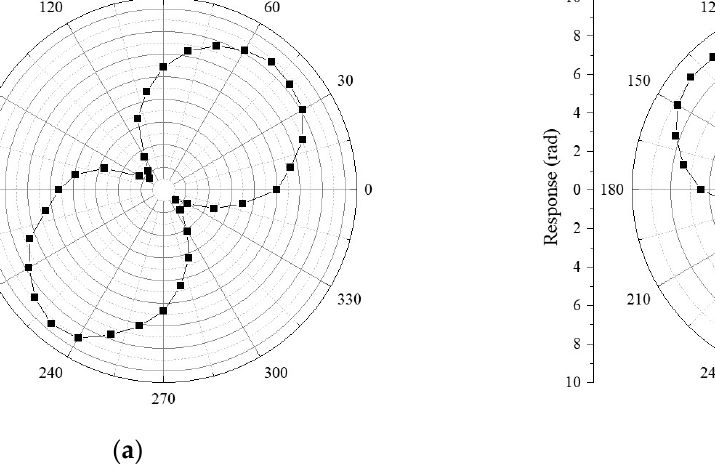
Figure 9. Directivity pattern of the phase response vs. the angle of the adjustable stage. ( a ) The value of the phase response of CFBG-FP1 vs. the angle of the adjustable stage. ( b ) The value of the phase response of CFBG-FP2 vs. the angle of the adjustable stage.